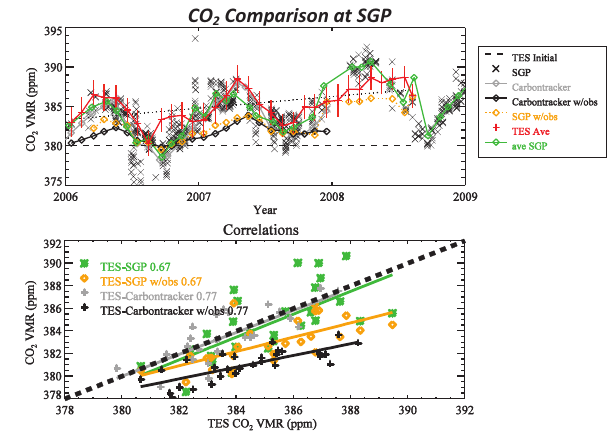
Fig. 12. Monthly averaged TES ( ∼ 5km, red), SGP aircraft data (2– 7km, green), and Carbontracker (black). SGP with the observation operator (orange) is influenced by the surface data and affected by seasonal variations in sensitivity. TES compared with SGP with the TES observation operator applied shows a high